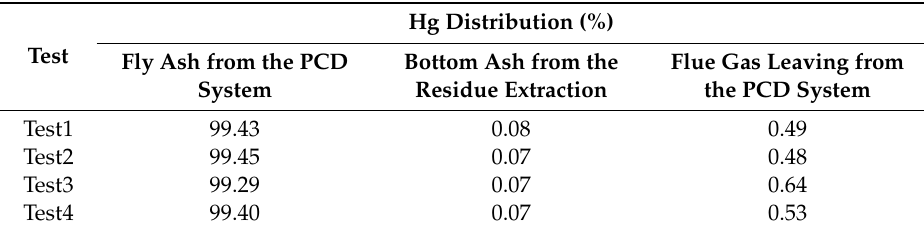
Table 2. Mass distribution of Hg after combustion.